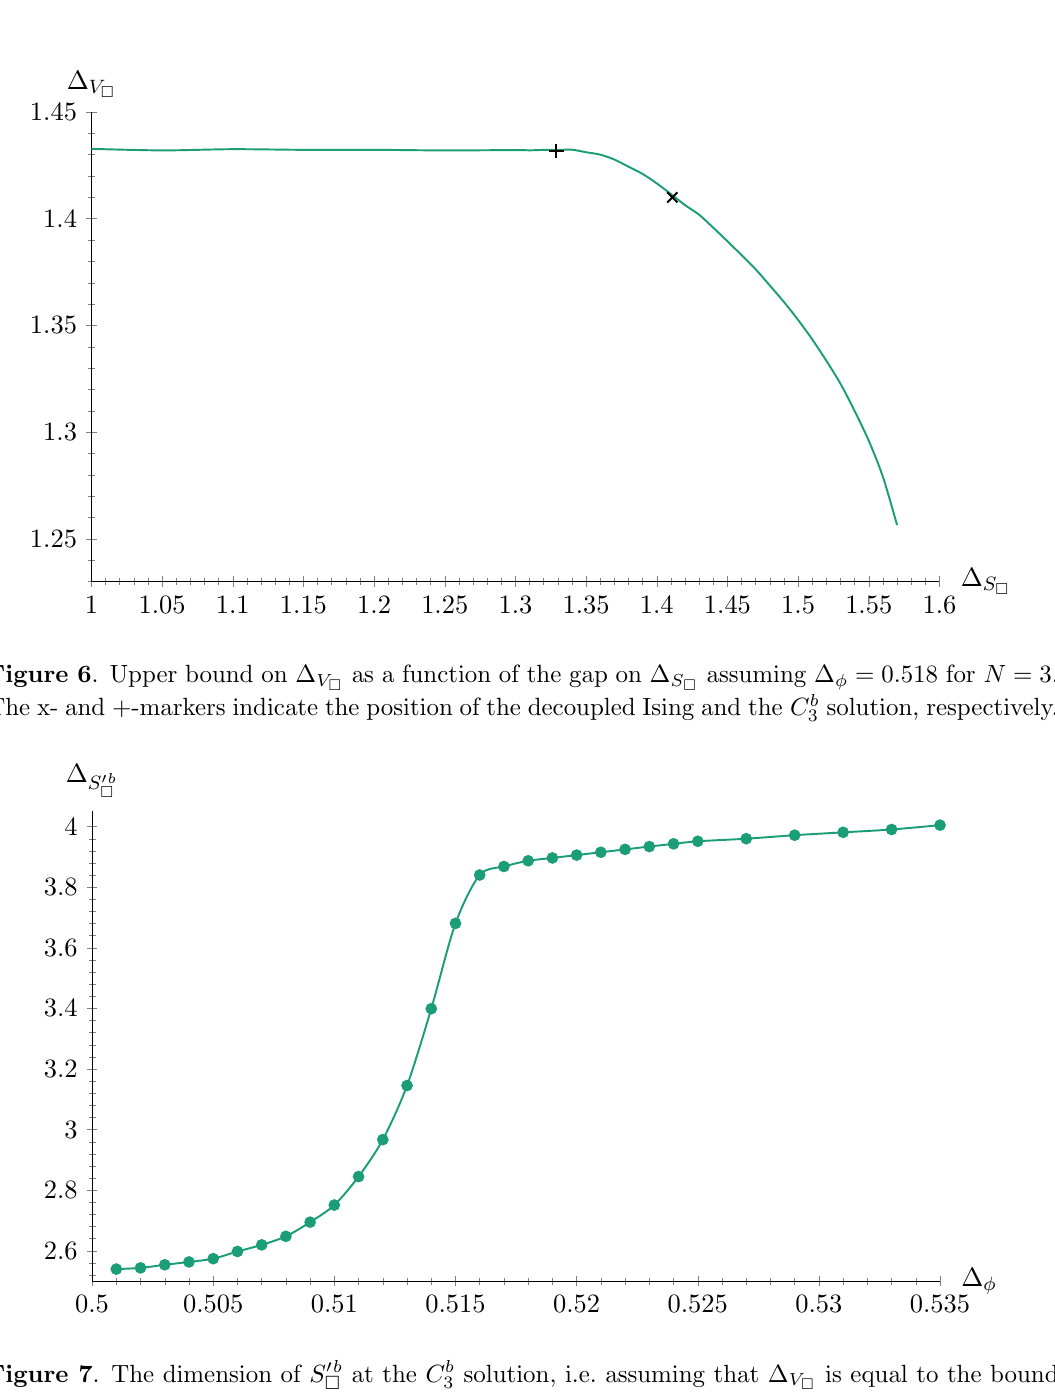
at the C b solution, i.e. assuming that (cid:1) V 3 (cid:3)